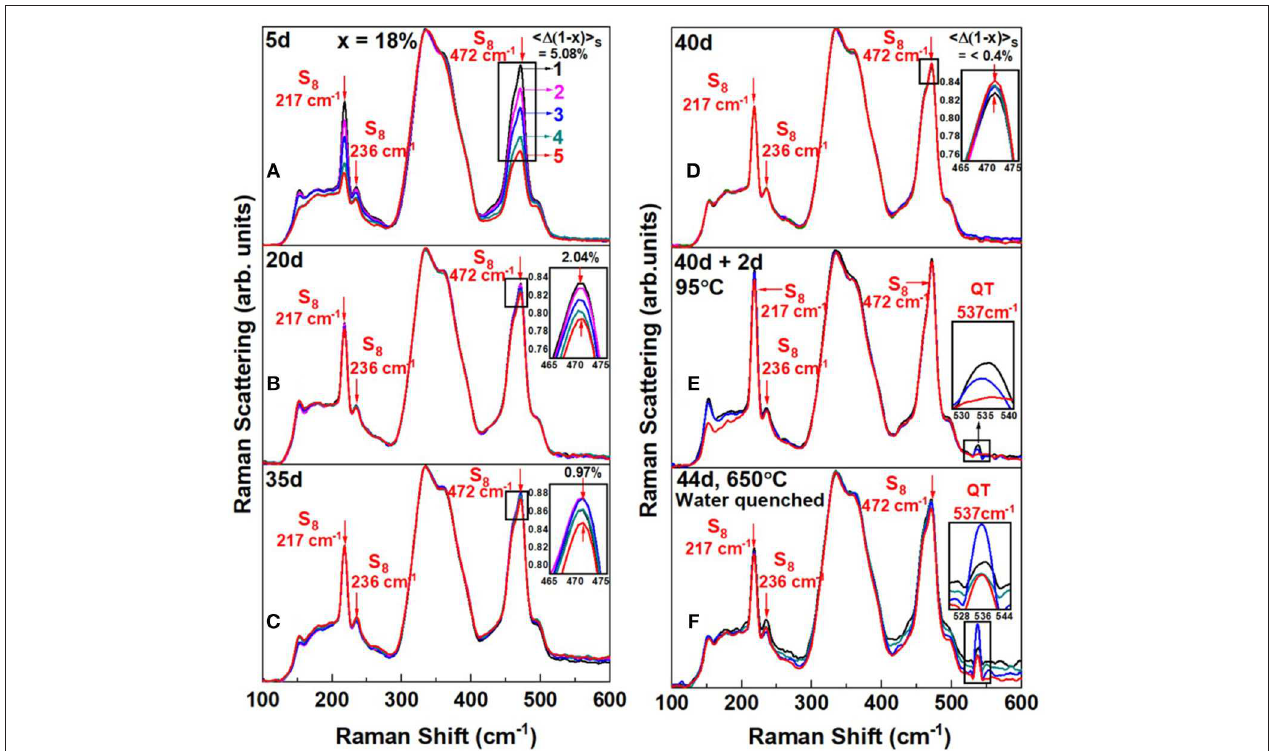
FIGURE 4 | FT—Raman scattering of an As 18 S 82 glass alloyed (A) for t r = 5d, displays a Sulfur—variance <1 (1–x) > S = 5.08%, (B) for t r = 20d, that variance decreases to 2.04(5)%, (C) for t r = 20d, it decreases further to 0.97(5)% (D) and for t r = 40d nearly saturates to 0.40(5)%. The reduced Sulfur variance across the 1.5 gram batch composition is taken as evidence of glass homogenizing upon continued alloying. In (D) , the homogenized melt/glass upon a thermal quench from 650 ◦ C displays a segregated backbone immersed in a sea of S 8 –rich fragments. In (E) heating the glass at T g + 10 ◦ C = 95 ◦ C for 2d, results in fragments of the backbone coalescing, and the observation of the 537cm − 1 mode of QT units. In (F) by taking the glass of (E) to 650 ◦ C for 2 days and water quenching it, leads to a precipitous growth of the 537 cm − 1 mode, and substantial amount of additional Sulfur alloying in the backbone inferred from the qualitative reduction of the S 8 ring—fraction between spectrum (E,F) . A schematic representation of the structural changes that underlie in going from (D) to (F) is shown in Figure 5 .